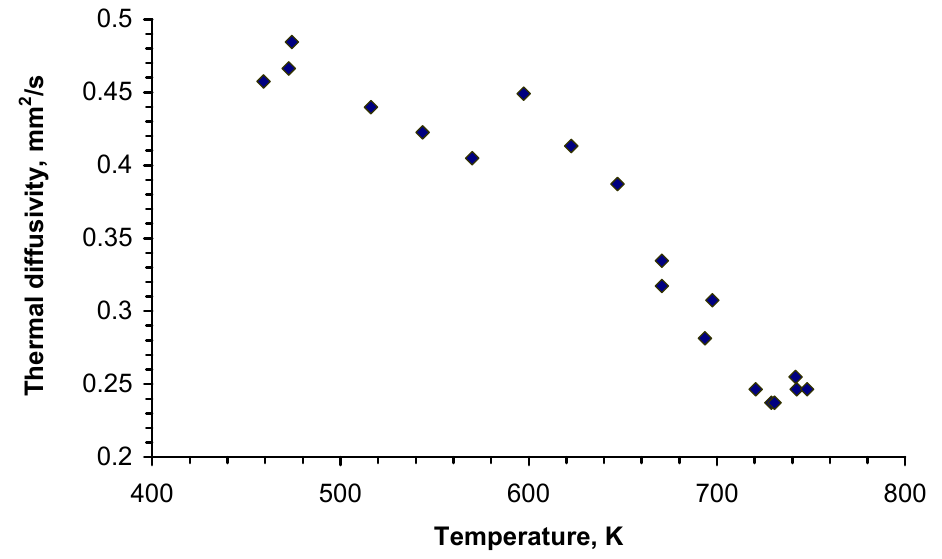
Figure 1. Thermal diffusivity of the Li 2 BeF 4 compound.